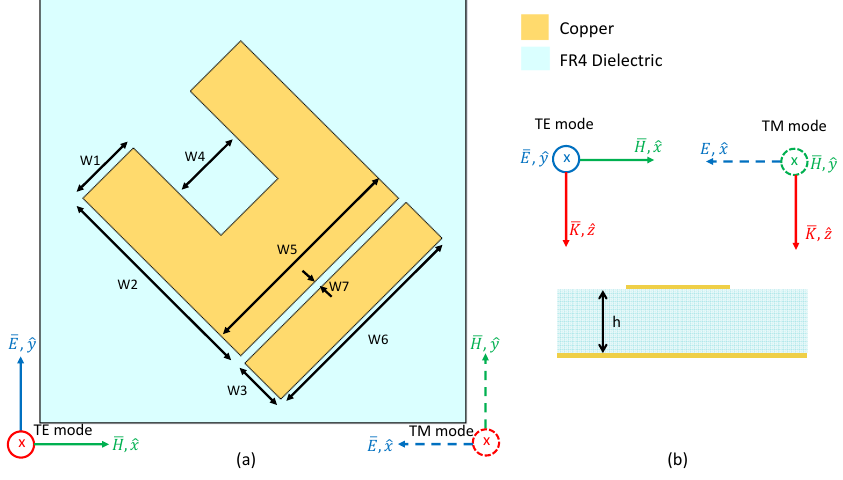
Figure 1. ( a ) Top view of the unit cell of the proposed absorber, ( b ) Cross sectional view of the uniet